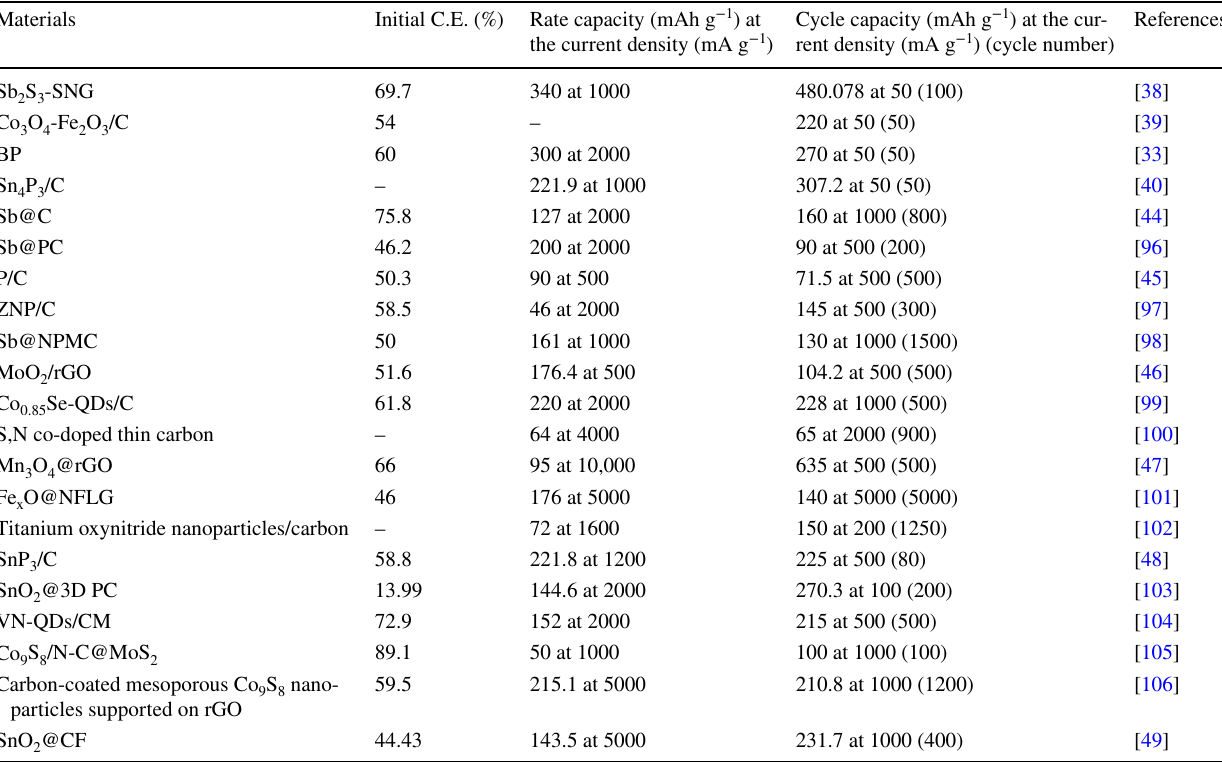
Table 1 Comparison of the state-of-the-art performances of 0D anode materials in PIBs Materials Initial C.E.